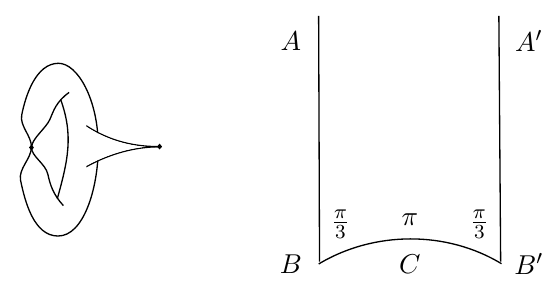
Figure 8 . Degenerate once punctured torus that is included in the Deligne-Mumford compactification M M M 1 , 1 of 1 , 1 (left). The orbifold 1 , 1 = H / SL (2 , Z ) is the interior of the keyhole with extra identification of the half-lines AB and A 0 B 0 and of the arcs CB and CB 0 [96] (right). There is an α = π total angle when one circles around C and an α = 2 π/ 3 total angle when one travels around B = B 0 . So, M 1 , 1 is not a smooth manifold, but indeed an